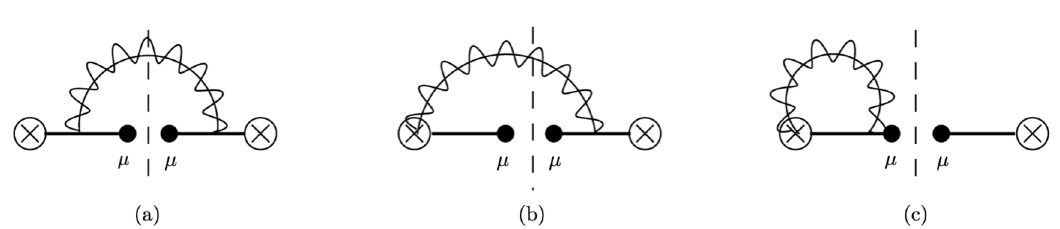
Figure 4 . Feynman diagrams for the fragmentation functions and the FJFs at one loop. The dotted lines denote the cut. The mirror images of (b) and (c) are omitted. The dots represent the observed particles in the final state. Note that ω is measured for the fragmentation function, while ω and p + are measured for the